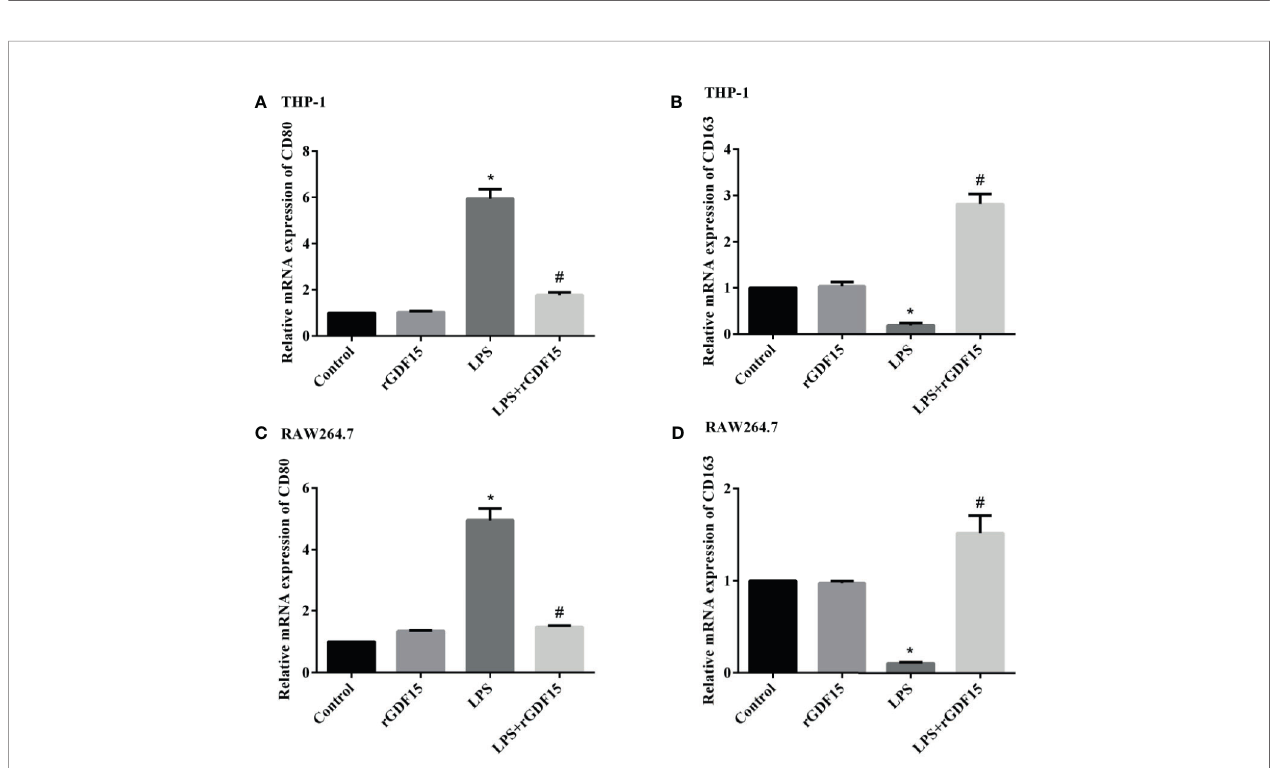
FIGURE 11 | Effect of rGDF15 on macrophage polarization. The expression levels of polarization markers mRNA were detected by qPCR. The relative mRNA expression of CD80 (A) and CD163 (B) in THP-1 cells; the relative mRNA expression of CD80 (C) and CD163 (D) in RAW264.7 cells. * P < 0.05, compare with the control group; # P < 0.05, compare with the LPS